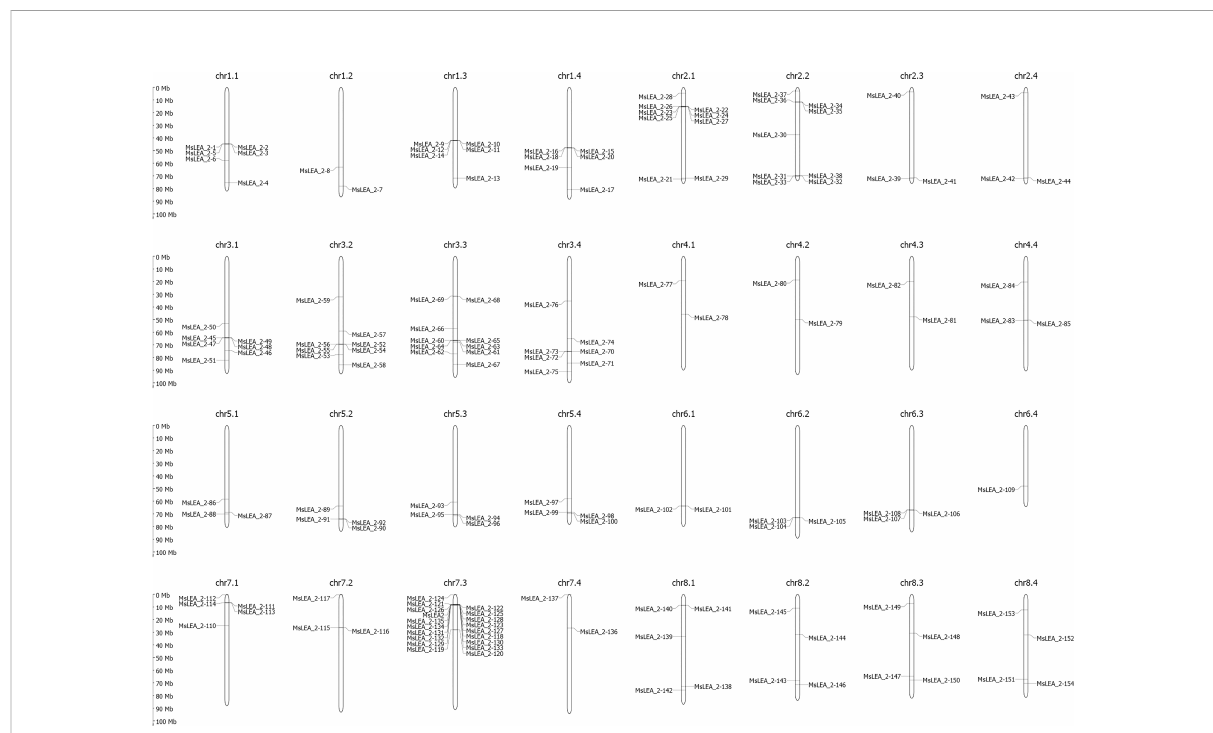
FIGURE 3 Chromosome distribution of MsLEA_2 gene family. Chromosome numbers shown at the tops of the chromosome. MsLEA_2 genes are labeled at the left or right of each chromosome. Scale bars on the left indicate the chromosome lengths